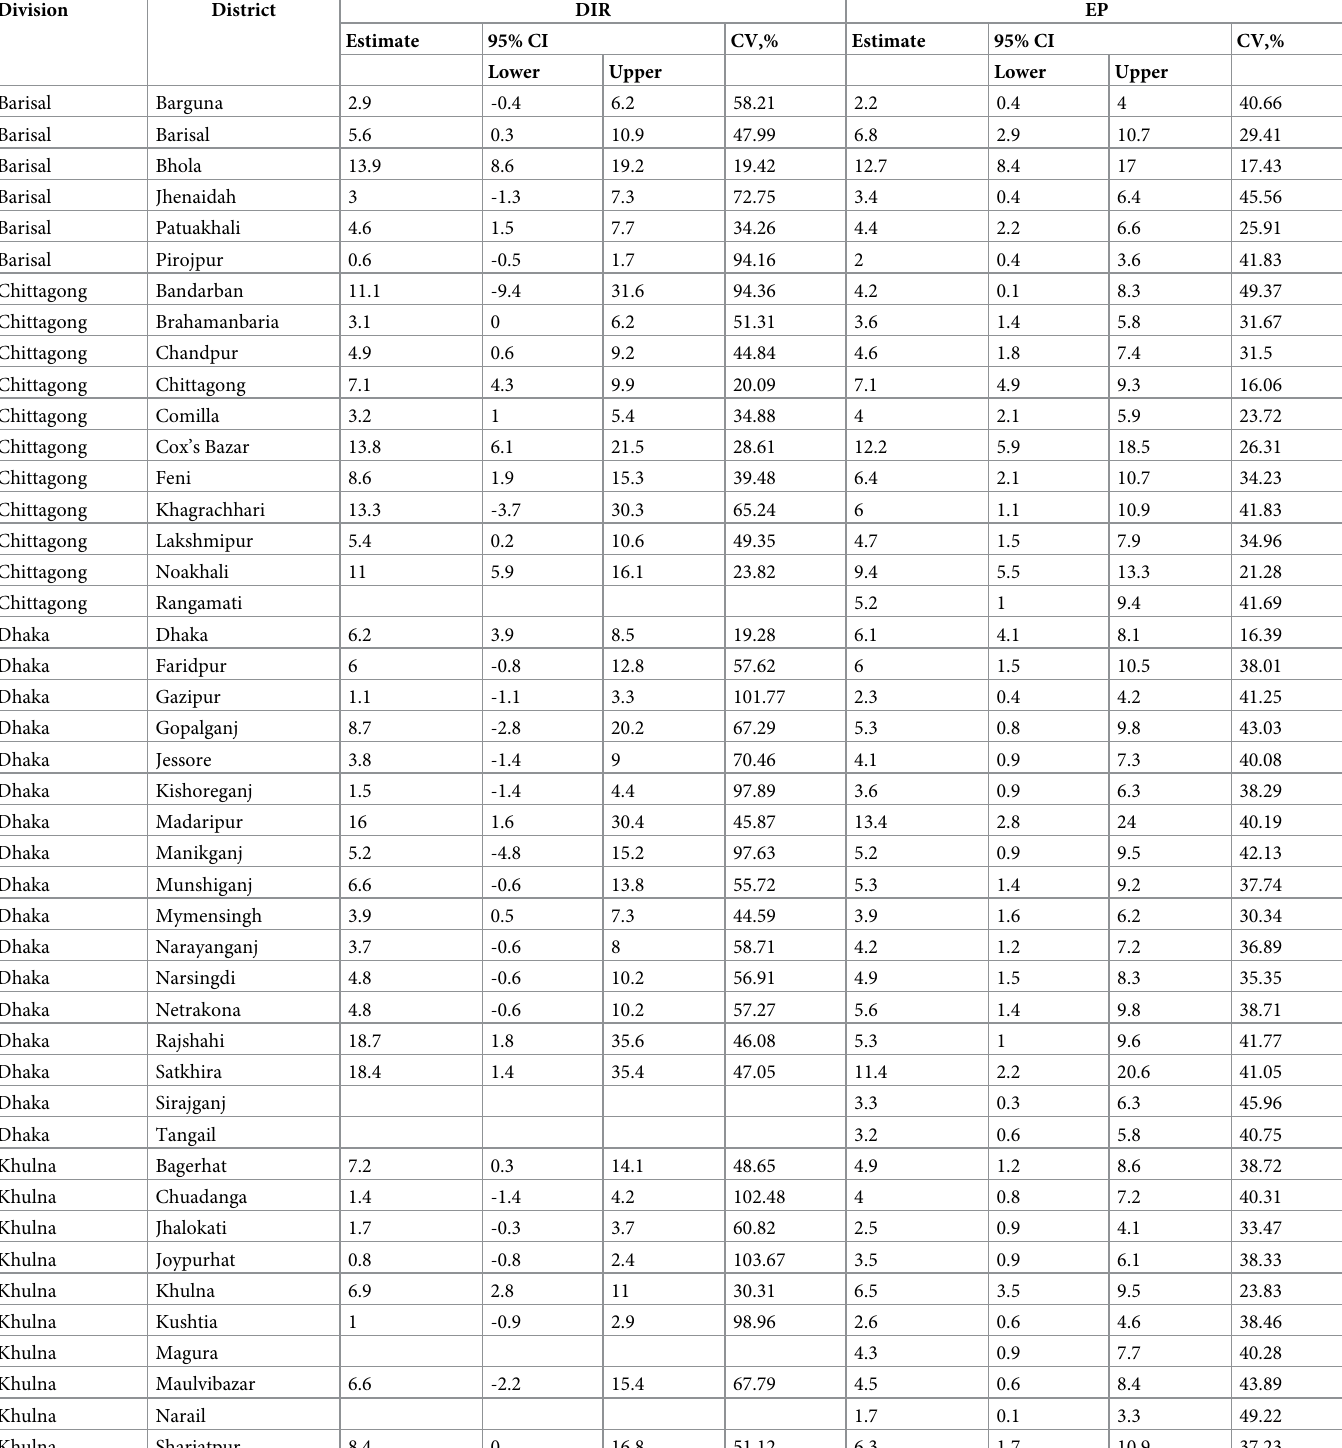
Table 3. Direct (DIR) and model-based (EP) estimates along with 95% confidence interval (95% CI) and percentage coefficient of variation (CV,%) of the diarrhoea incidence (%) by District in Bangladesh.